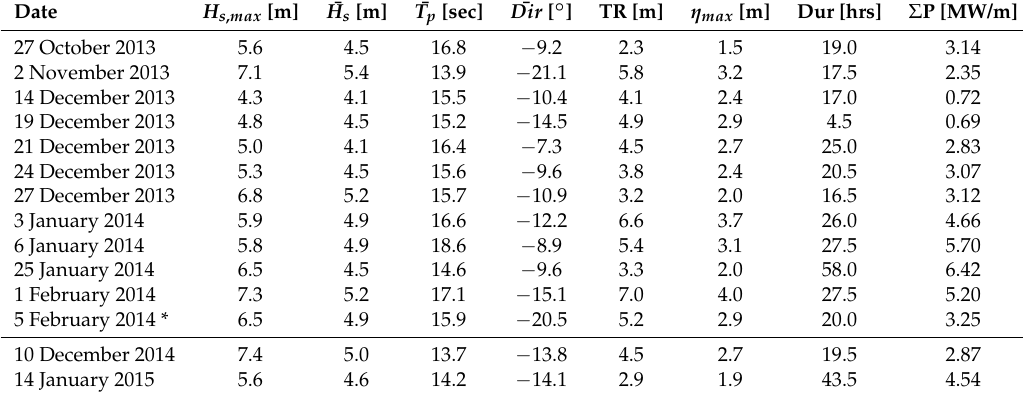
Table 1. Inshore wave conditions during storms. Storm wave conditions are measured during the time that instant wave power exceeds the 99% quantile threshold. H s represents the significant wave height (mean and maximum over the storm are respectively denoted as¯and max . The corresponding average peak period and average wave direction over the total storm duration (Dur) are respectively indicated by ¯ T p and ¯ Dir . TR means tidal range and η max indicates the water level at the peak of the storm intensity. Σ P is the accumulative hourly wave power over the duration of the